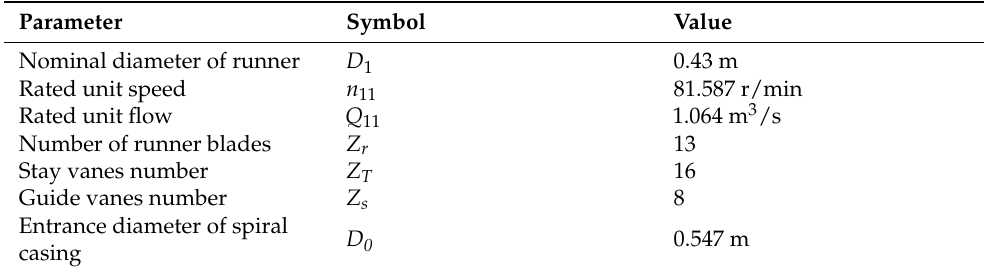
Figure 1. Prototype hydro turbine HLA551-LJ-43. Table 1. The parameters of the HLA551-LJ-43.